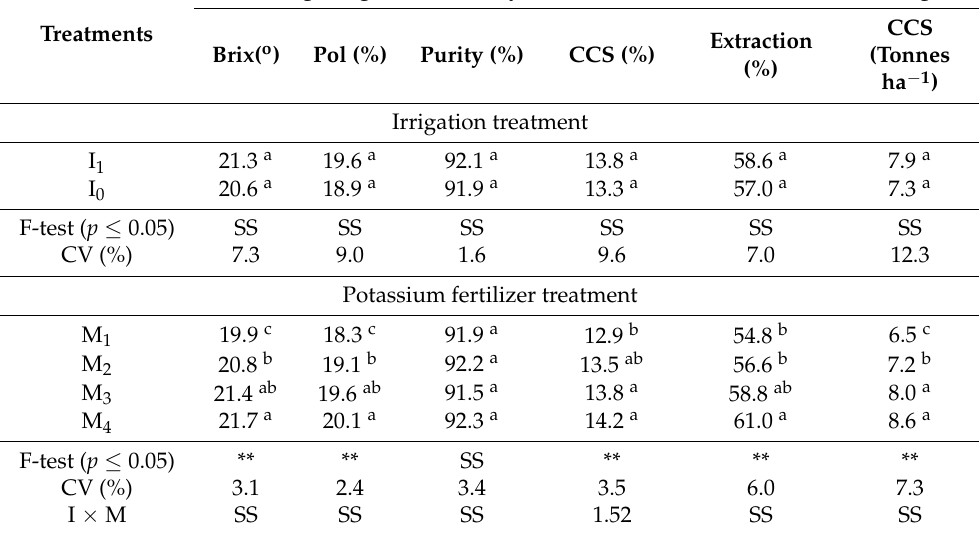
Table 7. Average sugarcane quality parameters 12 months after harvesting the seed crop under irrigation and potassium